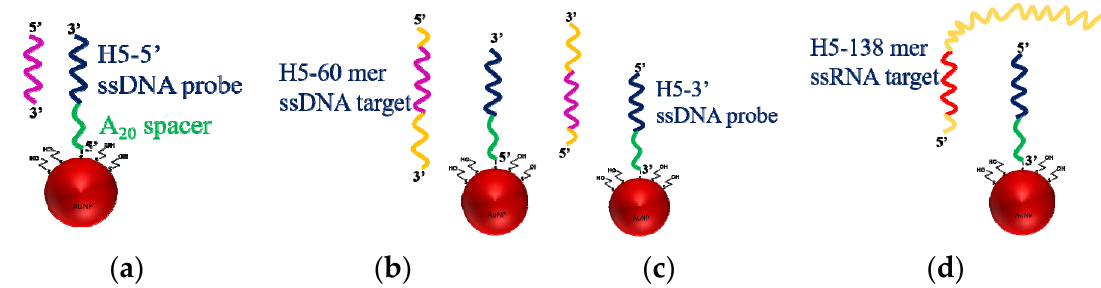
Figure 5. Schematic representation of the interaction between, ( a ) 30-mer H5-5’ ssDNA probe immobilized at 5’-end and 30-mer target ssDNA, ( b ) 30-mer H5-5’ ssDNA probe immobilized at 5’-end and 60-mer target ssDNA, ( c ) 30-mer H5-3’ ssDNA probe immobilized at 3’-end and 60-mer target ssDNA, and ( d ) 30-mer H5-3’ ssDNA probe immobilized at 3’-end and 138-mer target RNA.